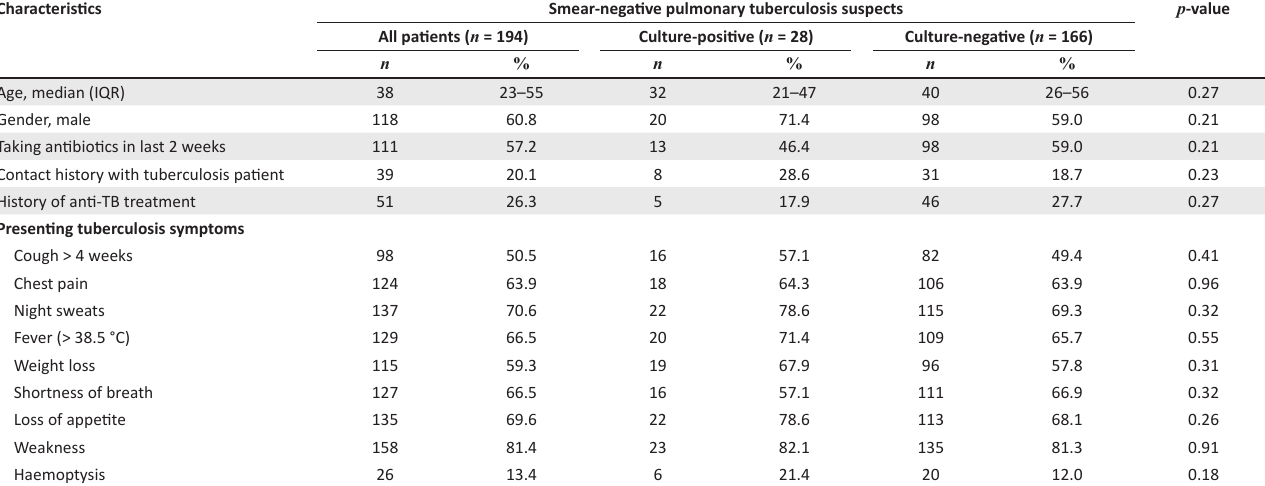
TABLE 1: Demographic and clinical characteristics of the study participants ( n = 194), Ethiopia, 2014.